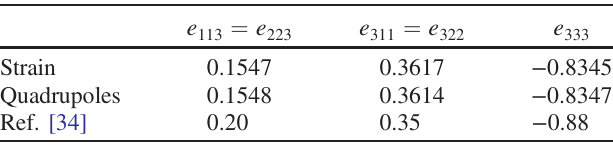
TABLE II. Clamped-ion piezoelectric coefficients (in C = m 2 ) of PbTiO 3 calculated via two different methods. “ Strain ” : Standard DFPT approach relying on the strain [33] and electric field response. “ Quadrupoles ” : From the quadrupole moments via Eq. (61). Literature values from Ref. [34] are shown for